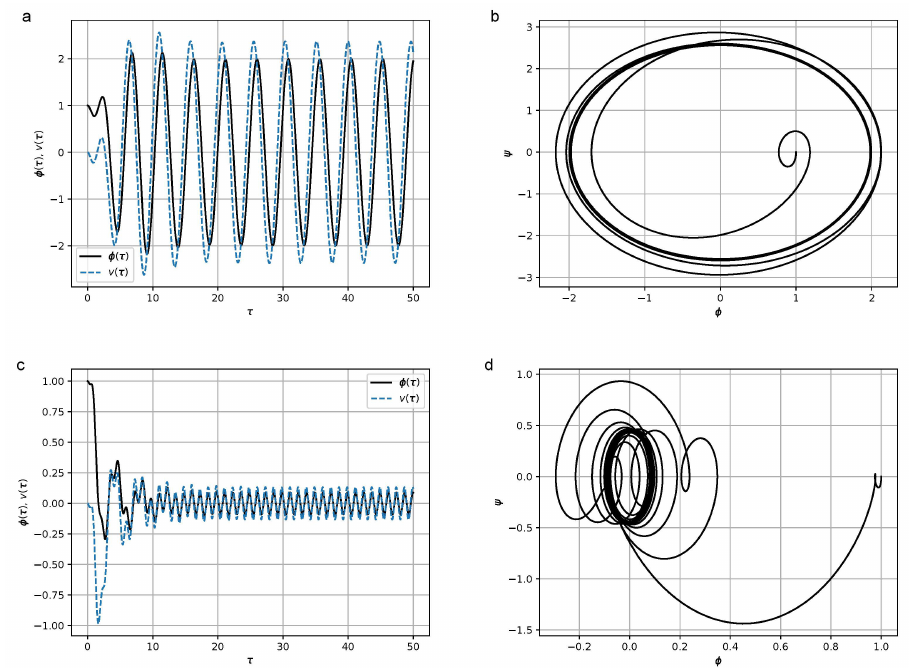
Figure 8. ( a ) Dependence of the declination angle of the pendulum, ϕ ( τ ) , and the stress, v ( τ ) , from the dimensionless time in the absence of the hysteresis term at Ω = 1.3 and H = 0; ( b ) phase portrait of the oscillations of the pendulum ψ ( ϕ ) at Ω = 1.3 and H = 0; ( c ) dependence of the declination angle of the pendulum, ϕ ( τ ) , and the stress, v ( τ ) , in the absence of the hysteresis term at Ω = 5.0 and H = 0; ( d ) phase portrait of the oscillations of the pendulum ψ ( ϕ ) at Ω = 5.0 and H = 0. Parameter values were σ = 1.5, ω = 1.2, and K = 2.0. Initial conditions were ϕ ( 0 ) = 1, ψ ( 0 ) = 0, and σ ( 0 ) =